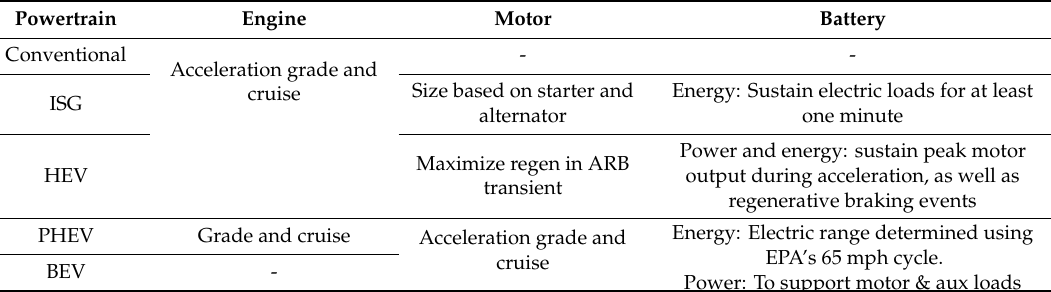
Table 3. Factors a ff ecting the component size for di ff erent powertrains.